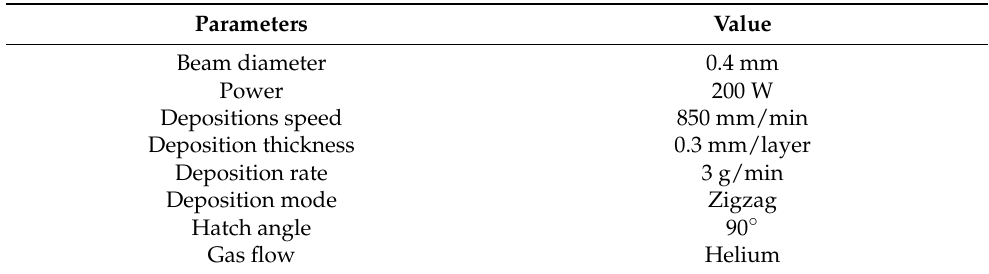
Figure 2. Schematic diagram of DED deposited samples: ( a ) composition gradient; ( b ) deposition direction. Table 2. DED 3D printing process parameters.